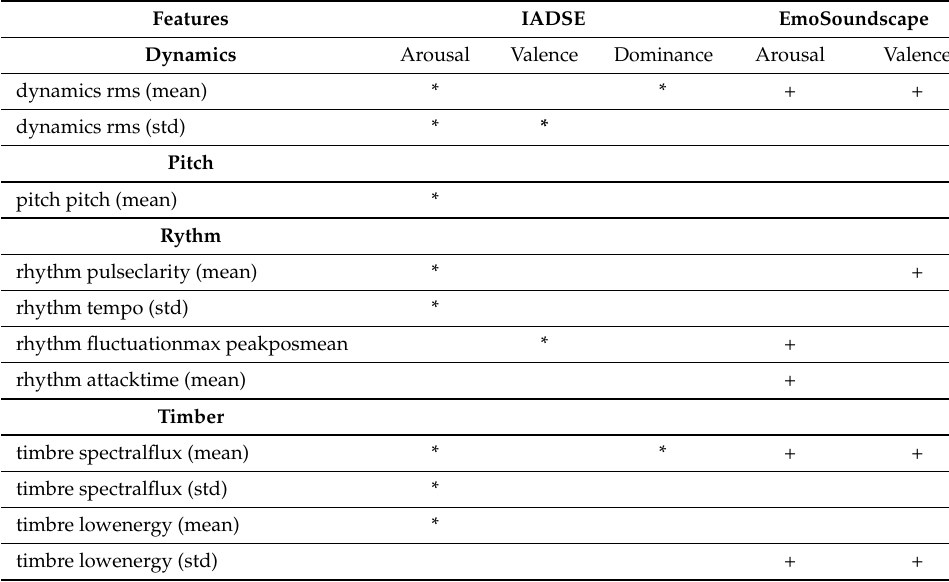
Table 10. Significant features for each prediction in the IADSE and EmoSoundscape datasets that showed common features among them. If any of these significant features had highly correlated features in its peer dataset, these correlated features were marked as (*) and (+) for the IADSE and EmoSoundscape datasets,